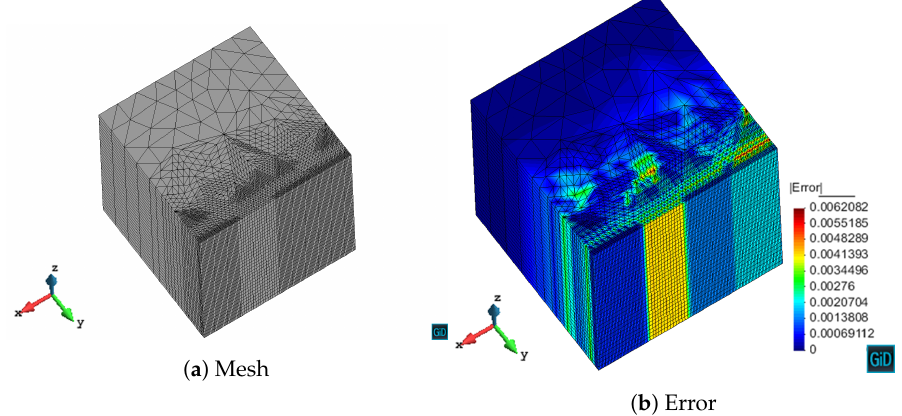
Figure 5. Presence of distorted elements in the refined